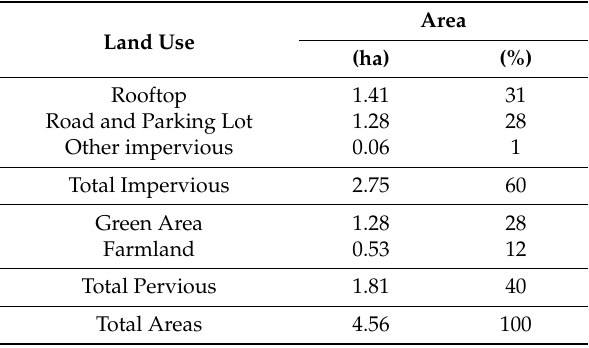
Table 1. Land-use characteristics of the urban catchment.